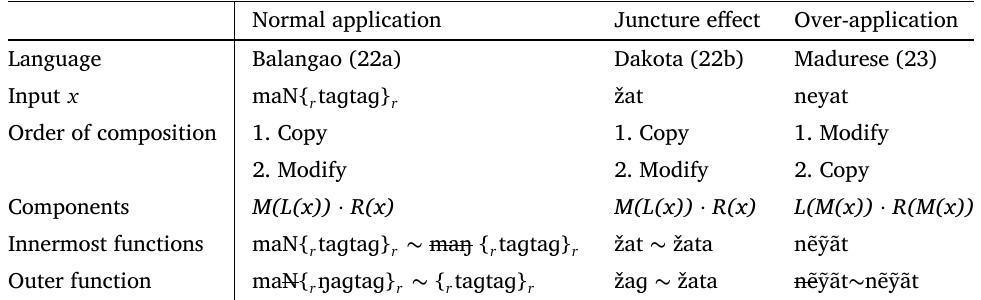
Table 10: Order of compositions for different reduplication-phonology interac- tions Normal